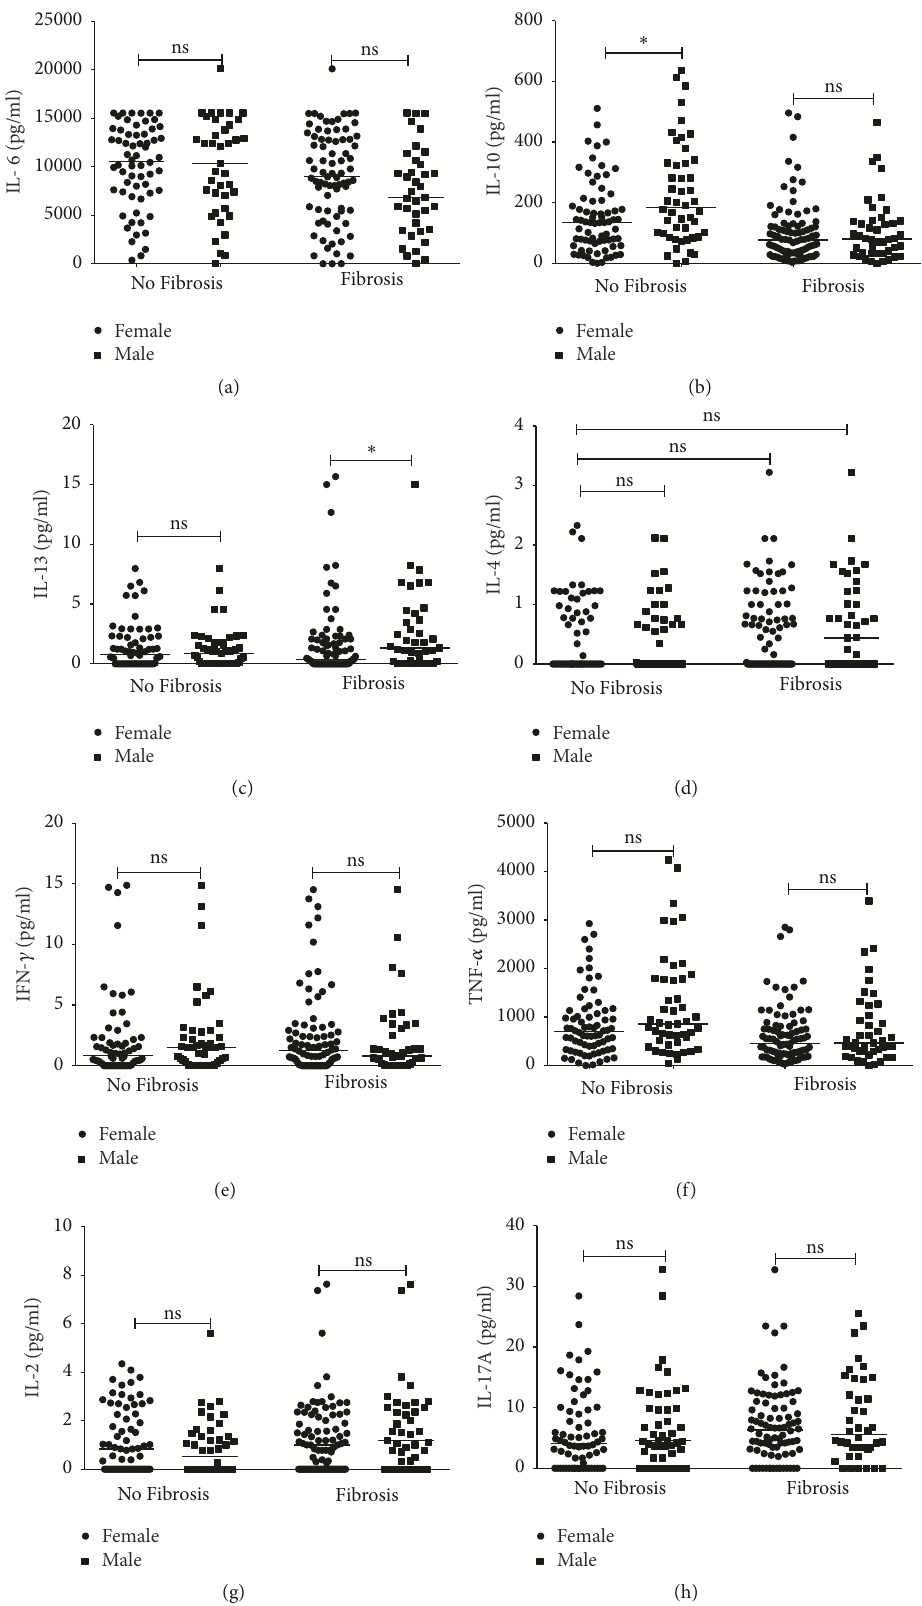
Figure 2: Cytokine Levels in female and male participants with or without fibrosis. Median values are shown by the horizontal line. The Mann–Whitney test was used to compare differences in median cytokine expression in individuals without fibrosis and those with fibrosis. ∗ 𝑝 ≤ 0.05